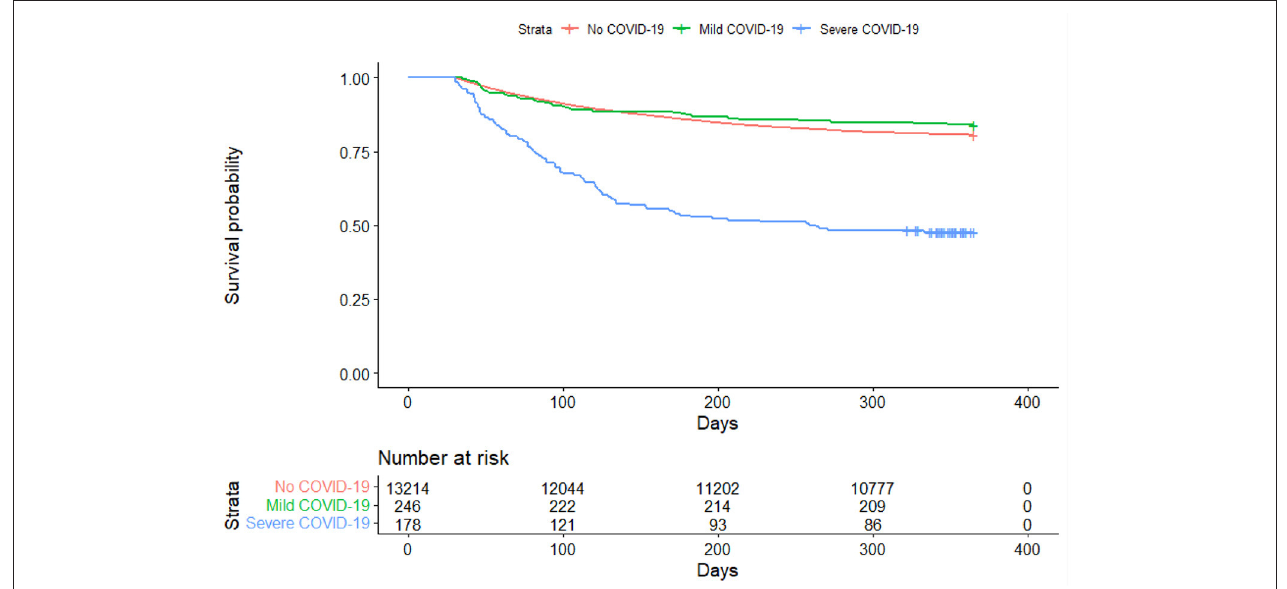
FIGURE 1 | Kaplan-Meier curve comparing all-cause mortality between COVID-19 positive and COVID-19 negative patients.